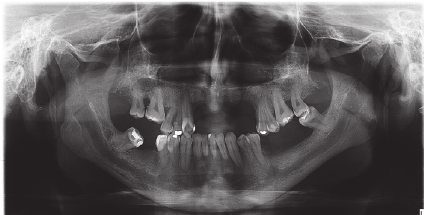
Figure 3: CBCT panoramic slice.